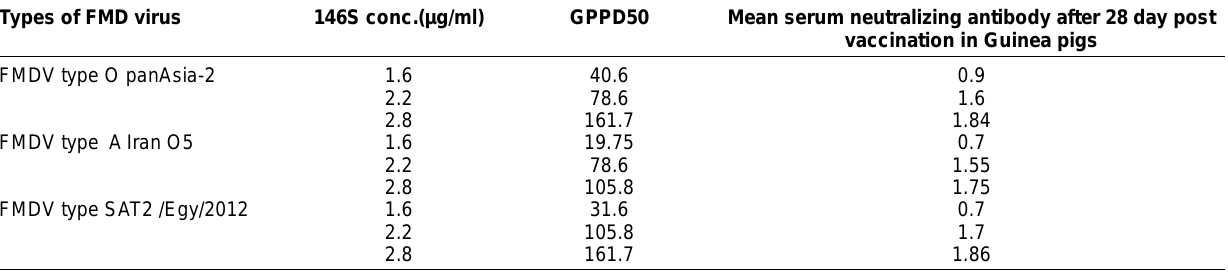
Table-5. GPPD of different 146S concentrations of FMD virus serotypes and mean serum neutralizing antibody after 28 day 50 post vaccination in Guinea pigs Types of FMD virus